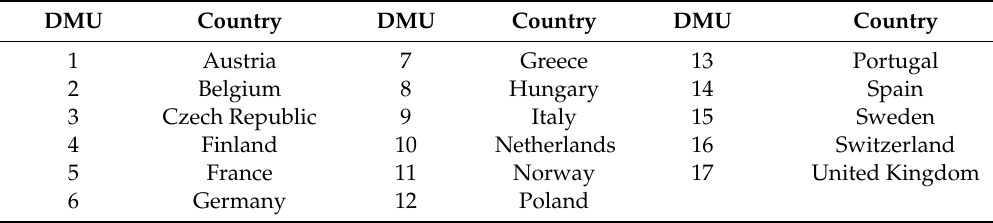
Table 1. List of 17 selected countries (decision-making